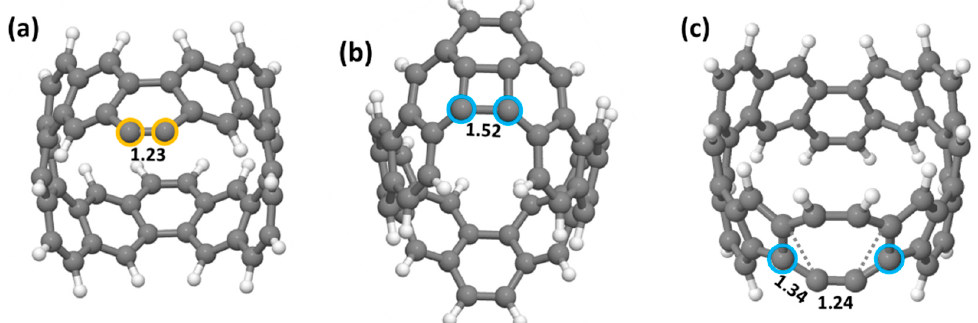
Figure 2. Molecular structures of C 48 H 23 , i.e., 1H-loss structures from an ( a ) exterior site and ( b ) interior site. Orange and blue dotted circles indicate dehydrogenated sites. ( c ) a pentagon-heptagon structure formed by Stone-Wales bond rotation of structure ( b ). Grey and white spheres indicate carbon and hydrogen atoms, respectively.